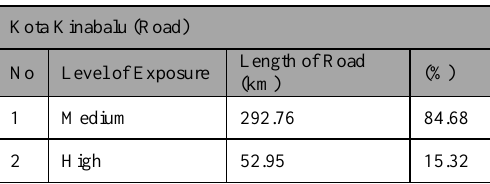
Table 2: Level of road exposure toward hazard in Kota